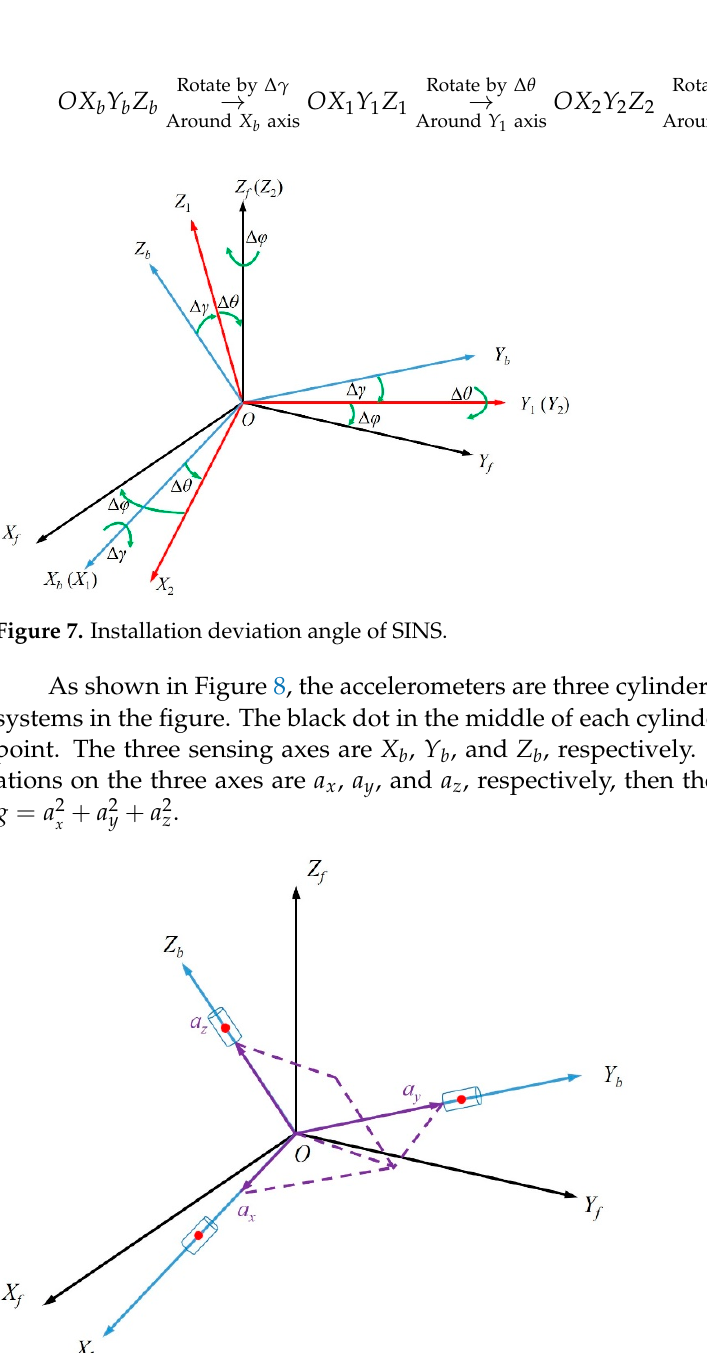
Figure 9. Roll deviation angle of SINS.